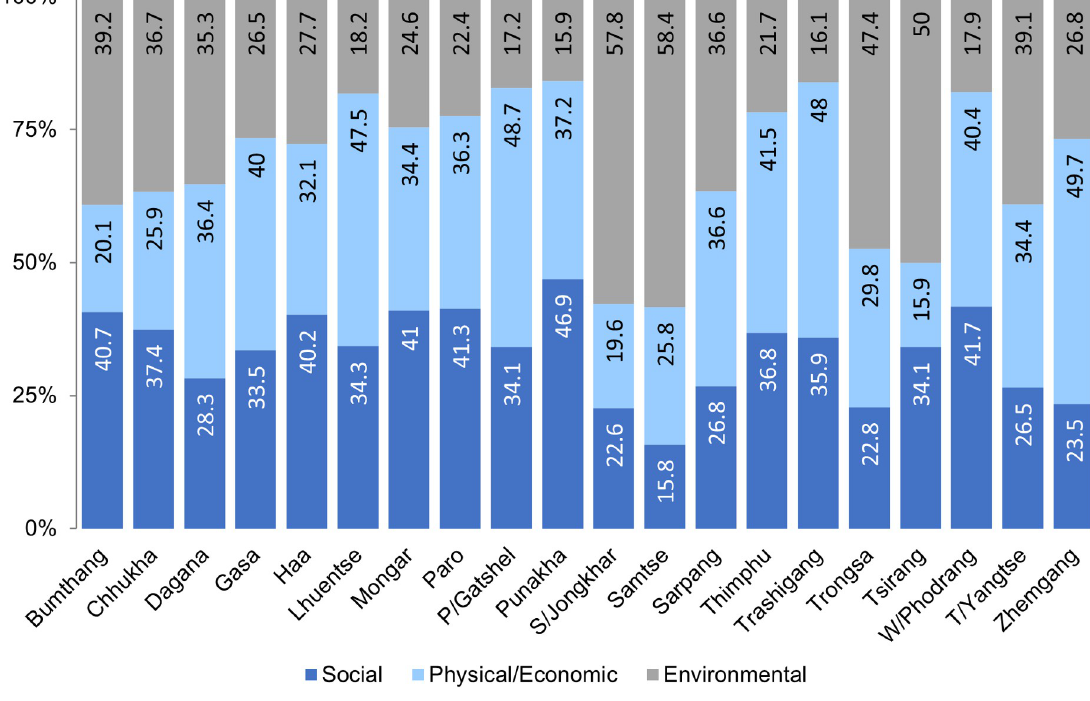
Fig 8. Priority ranking of base indicators under each district as an outcome of